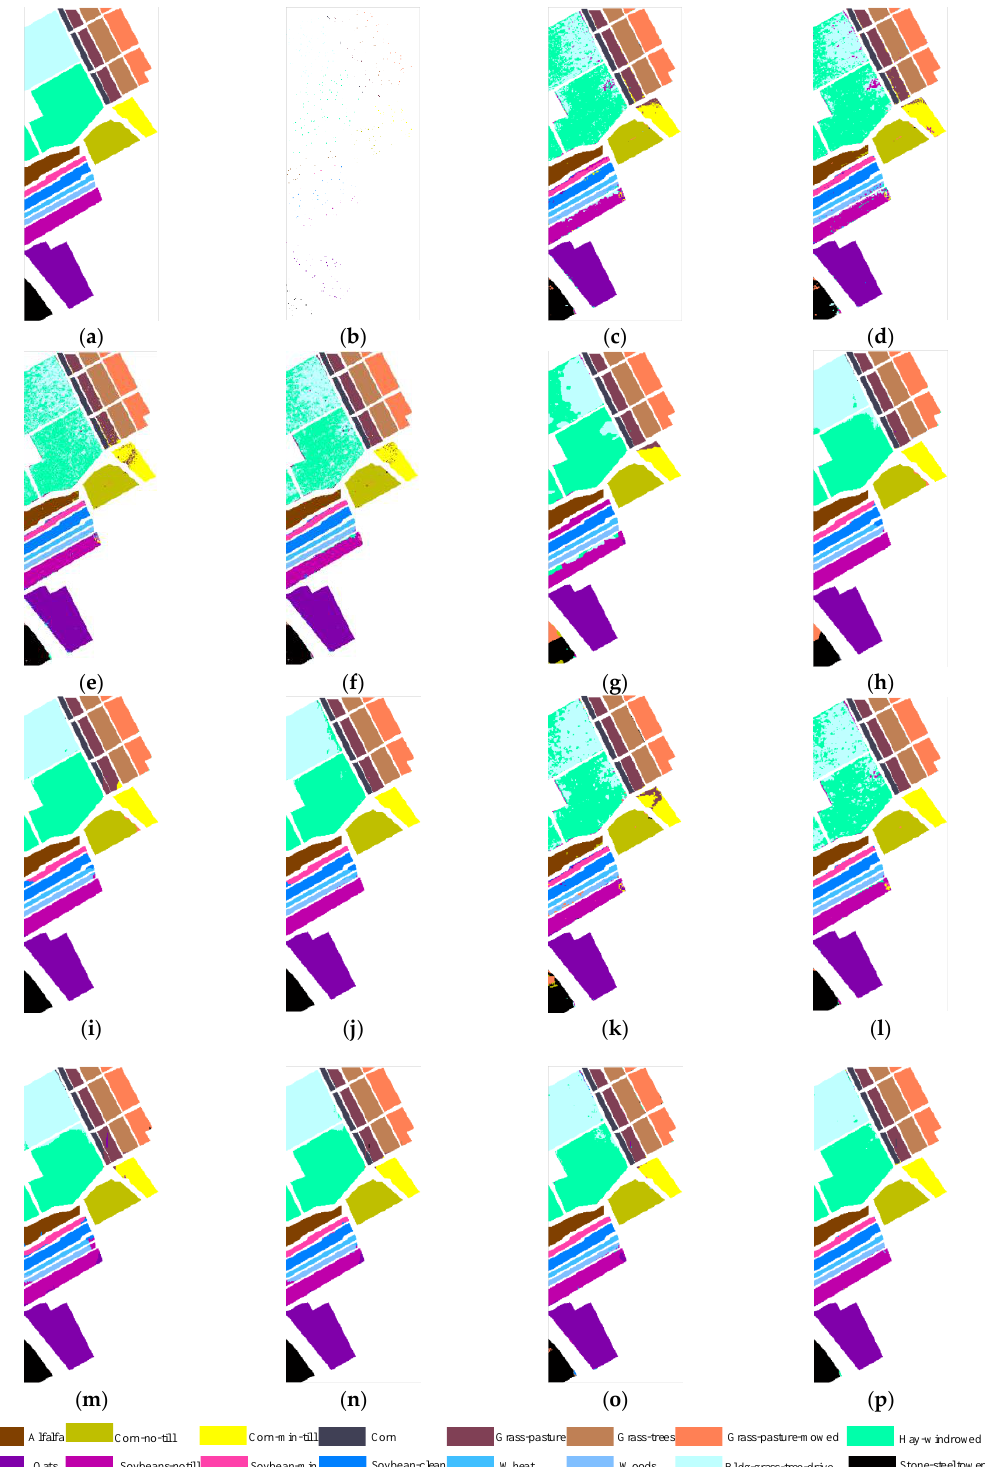
Figure 9. Classification maps of different methods on the Salinas Valley dataset ( a ) ground; ( b ) training; ( c ) SVM, OA = 87.99%; ( d ) PCA-SVM, OA = 87.45%; ( e ) LDM, OA = 88.96%; ( f ) PCA-LDM, OA = 89.19%; ( g ) EPF, OA = 91.37%; ( h ) IFRF, OA = 97.52%; ( i ) PCA-EPFs, OA = 98.68%; ( j ) LDM-FL, OA = 98.76%; ( k ) CF-SVM, OA = 89.20%; ( l ) CF-LDM, OA = 90.56%; ( m ) DTRF-SVM, OA = 96.71%; ( n ) DTRF-LDM, OA = 98.52%; ( o ) CFDTRFF-SVM, OA = 97.93%; ( p ) CFDTRF-LDM, OA = 99.16%. The classification results for Salinas Valley are shown in Figure 9, while Tables 3 and 4 shows the accuracies of OA, AA and Kappa for each class of the different methods, and also indicates CFDTRF-LDM achieved the best accuracy, when OA = 99.16%, AA = 98.71% and Kappa = 99.06%. Furthermore, the accuracies reached 100% of four classes for CFDTRF-LDM. This experiment demonstrates that the classification performance was improved compared to other classification methods. Table 4. Comparison of classification accuracies (in percent) provided by seven methods for Salinas Valley (part B). Ground